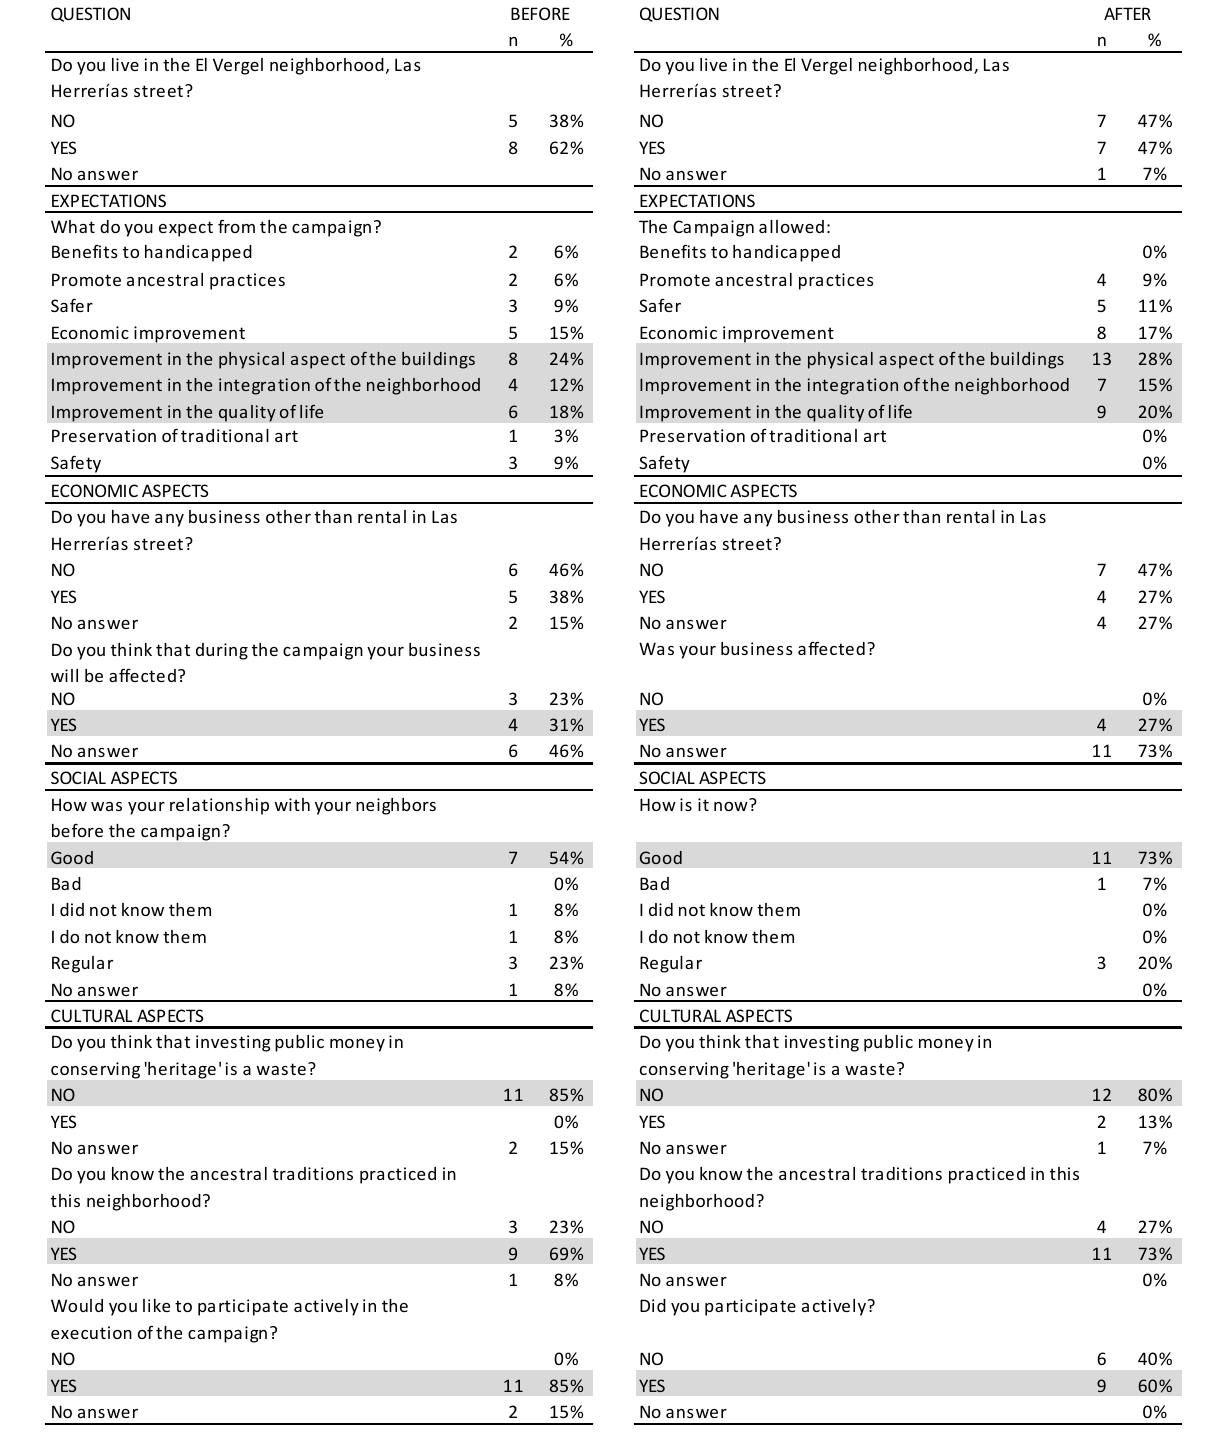
Table 3. Comparison of the owners’ perception in relation to the economic, social and cultural aspects. Sample size of 13 (before) and 15 (after) the maintenance campaign. Source: The